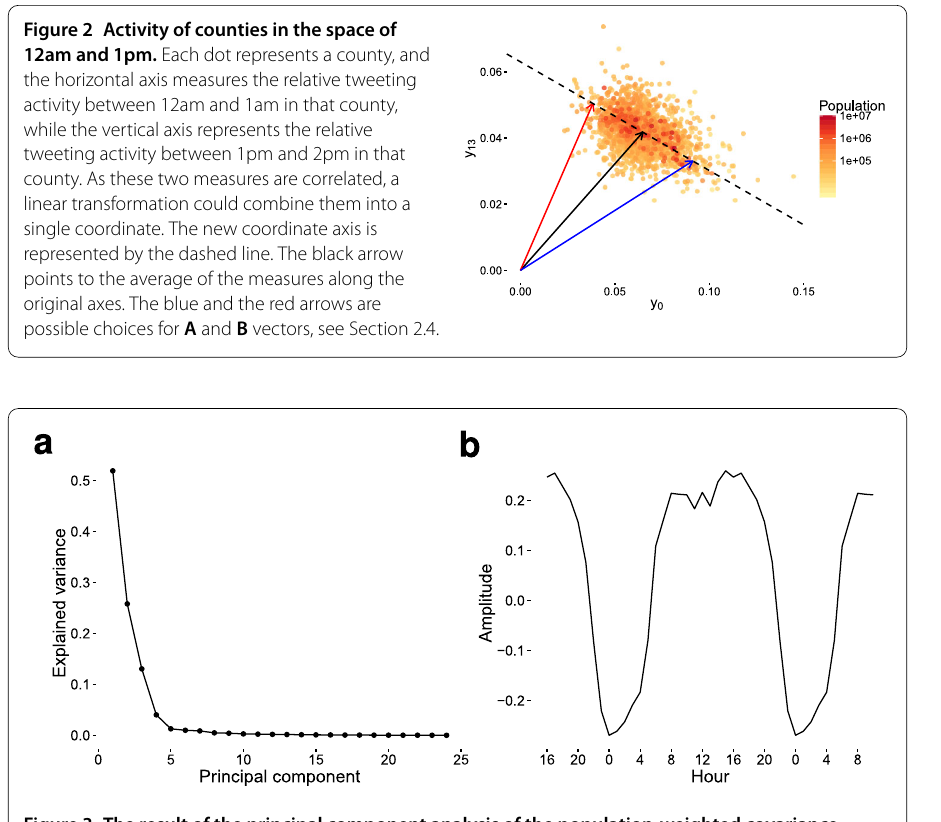
Figure 3 The result of the principal component analysis of the population-weighted covariance matrix. (a) Proportion of explained variance for the principal components of the covariance matrix. Only the first four components carry a share of variance significantly greater than zero. (b) Principal component corresponding to the largest principal value. The amplitude of vector components is plotted, each vector coordinate corresponds to an hour ranging from 0 to 23. The vector components are positive from 5am to 8pm, and negative